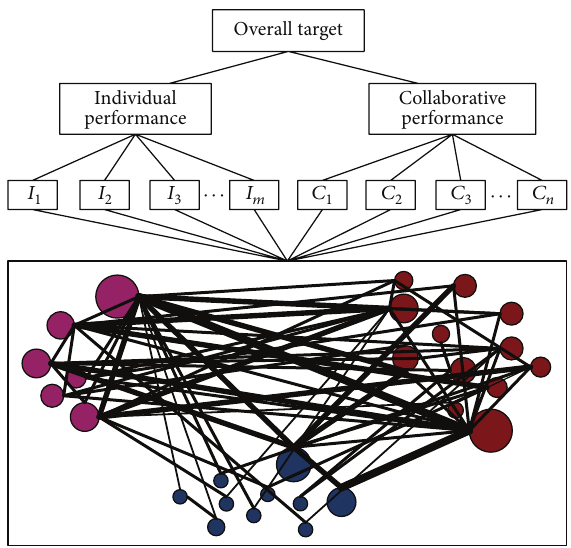
Figure 2: A cross-functional contractor selection problem frame-